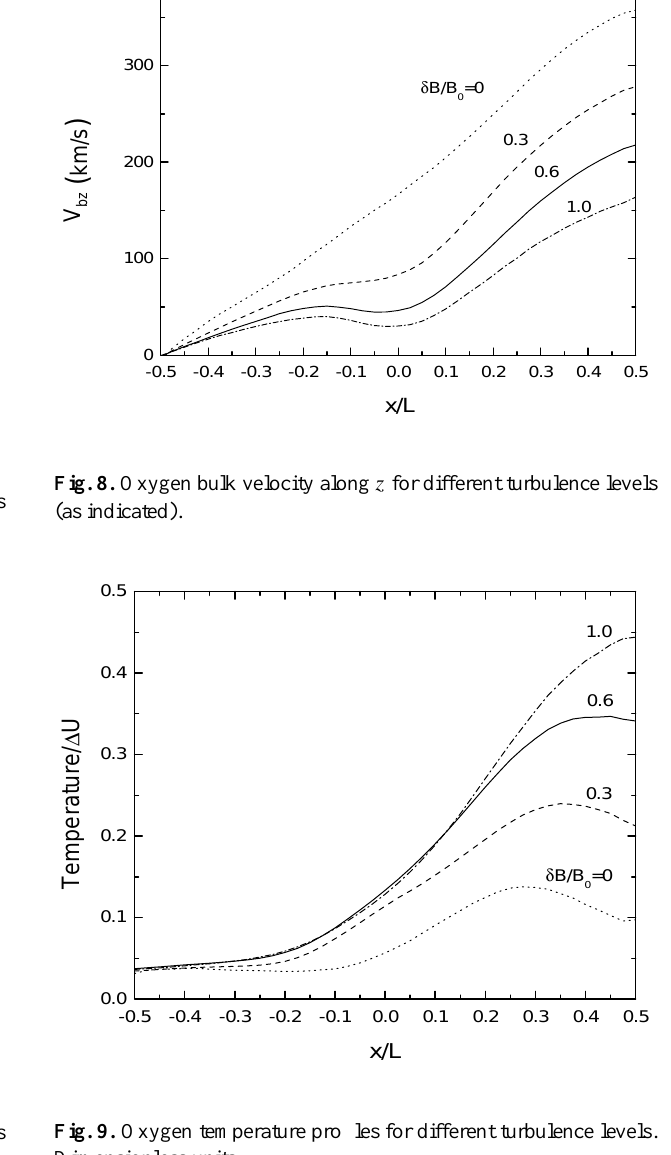
Fig. 9. Oxygen temperature profiles for different turbulence levels. Dimensionless